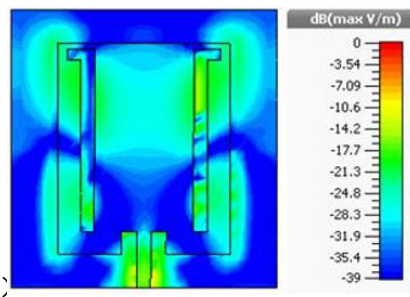
Fig. 8. 3D Radiation Pattern at (a) 4.4GHz, (b) 6.2GHz and